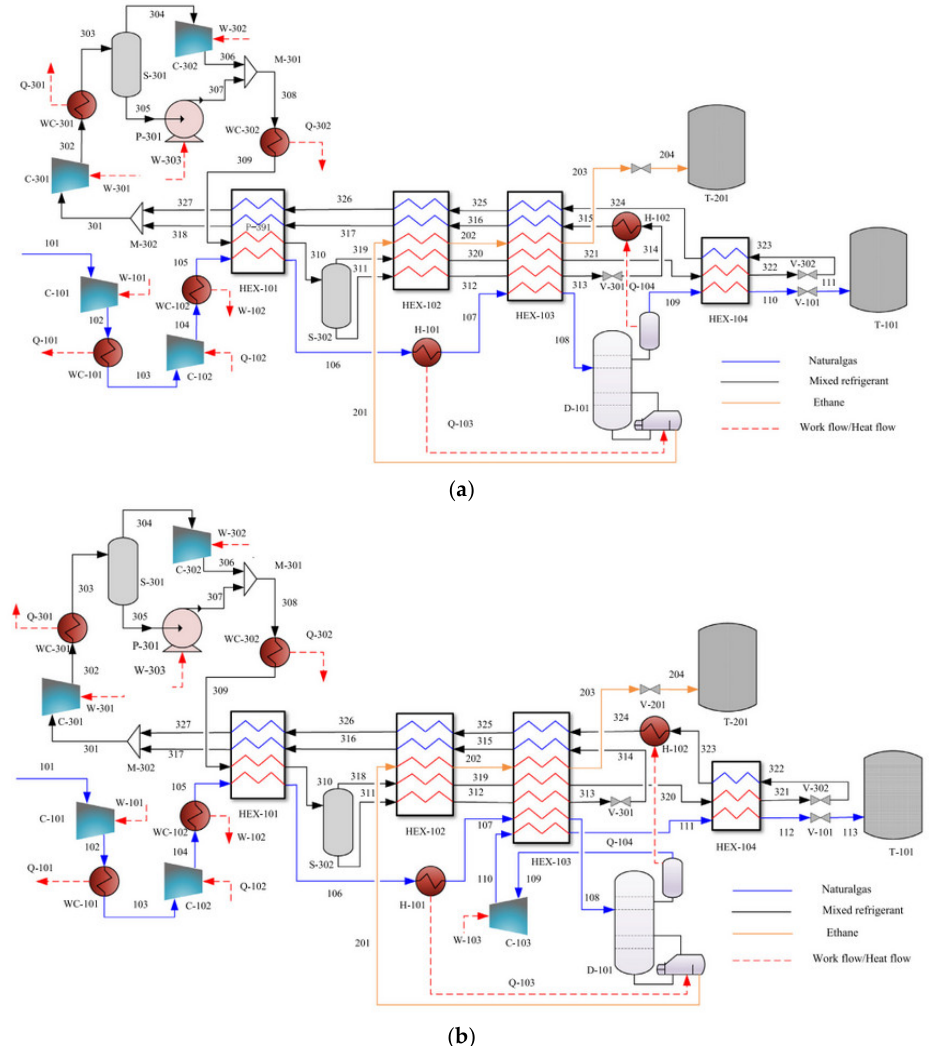
Figure 44. Flow diagram of SMR natural gas liquefaction process integrated with ethane separation: ( a ) process 1; ( b ) process 2 [174]. Reproduced with permission from International Journal of